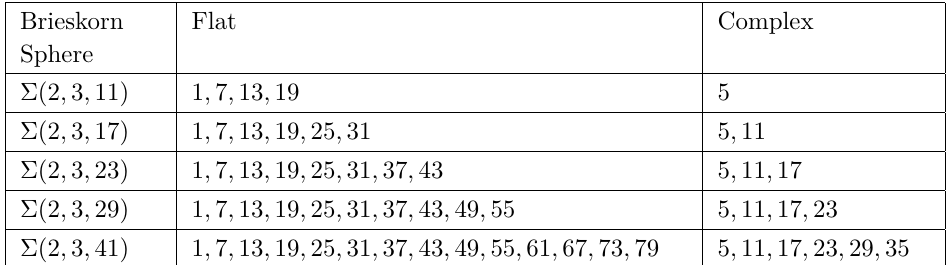
Table 2. The first five of Brieskorn spheres Σ(2 , 3 , 6 n + 5) and their poles corresponding to flat and complex SL(2 , C )